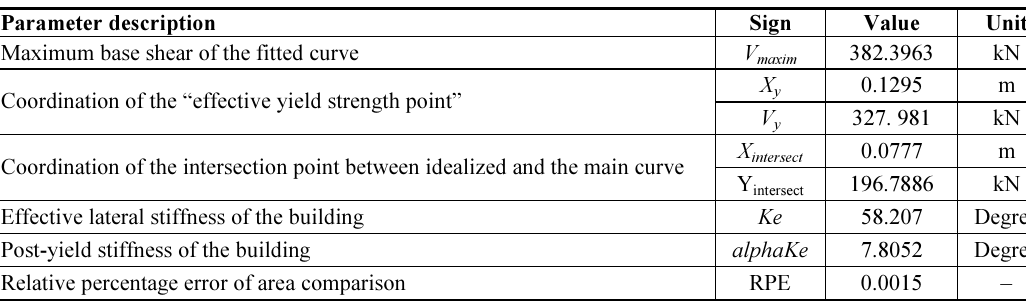
Table 5. Final results of applying idealization program for 6f3s4l4b3r Parameter